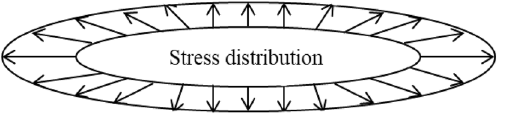
Figure 9. Schematic diagram of stress distribution of ellipsoid coal sample joint